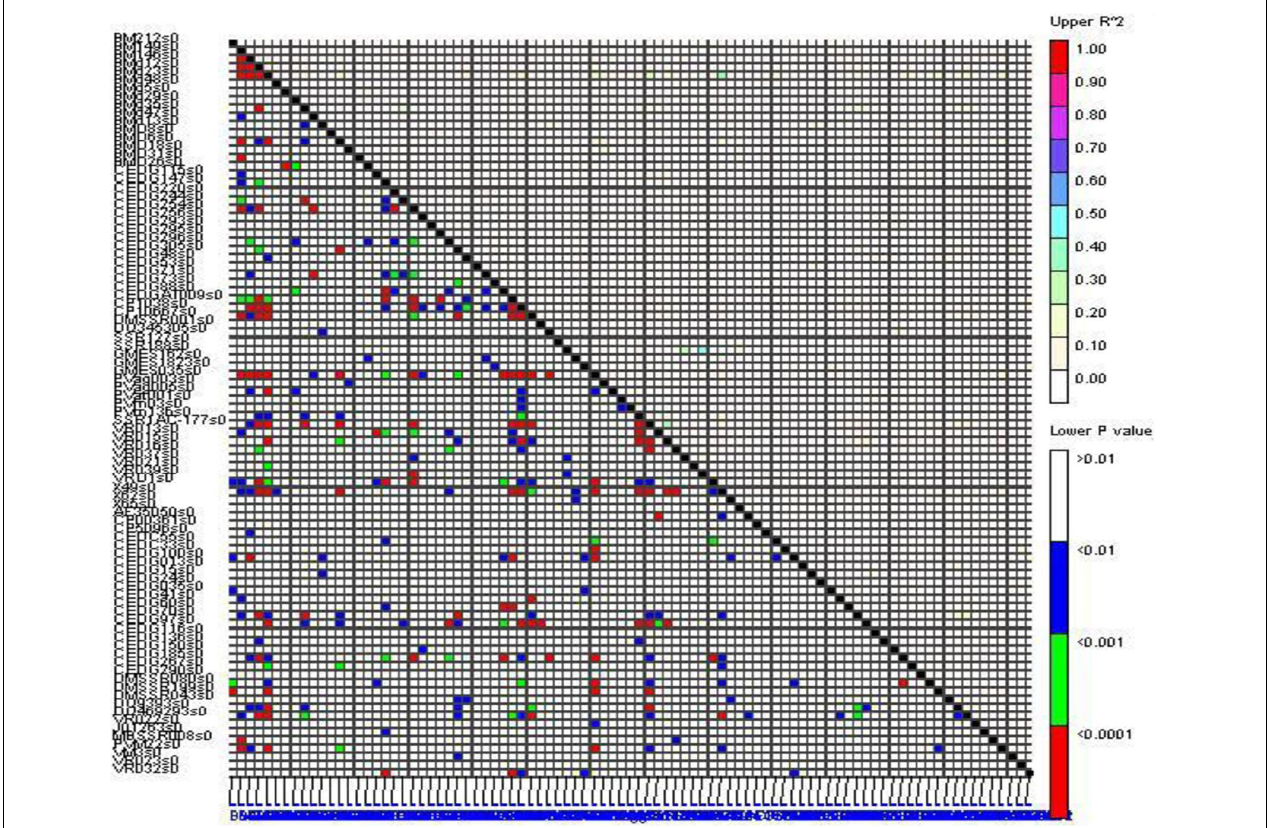
FIGURE 5 | Triangle heat plot showing pairwise locus combination in mung bean